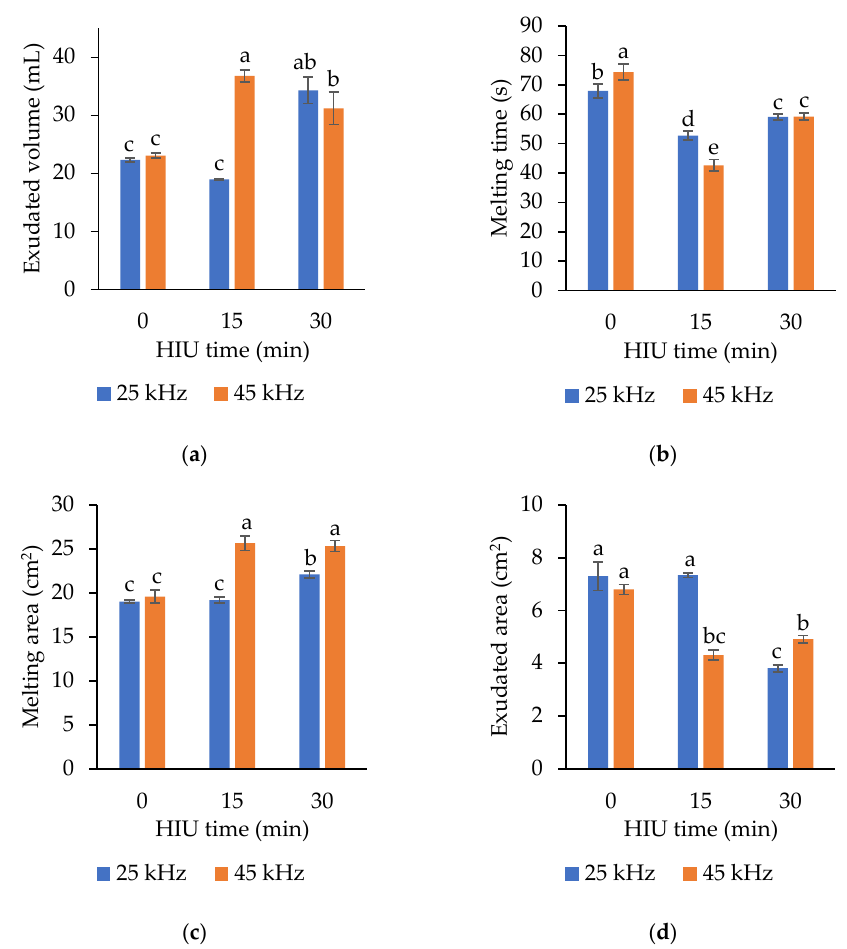
Figure 2. Effects of HIU frequency x time of application to fresh raw milk on ( a ) exudate volume, ( b ) melting time, ( c ) melt area, and ( d ) exudate area in Oaxaca cheese. Data are expressed